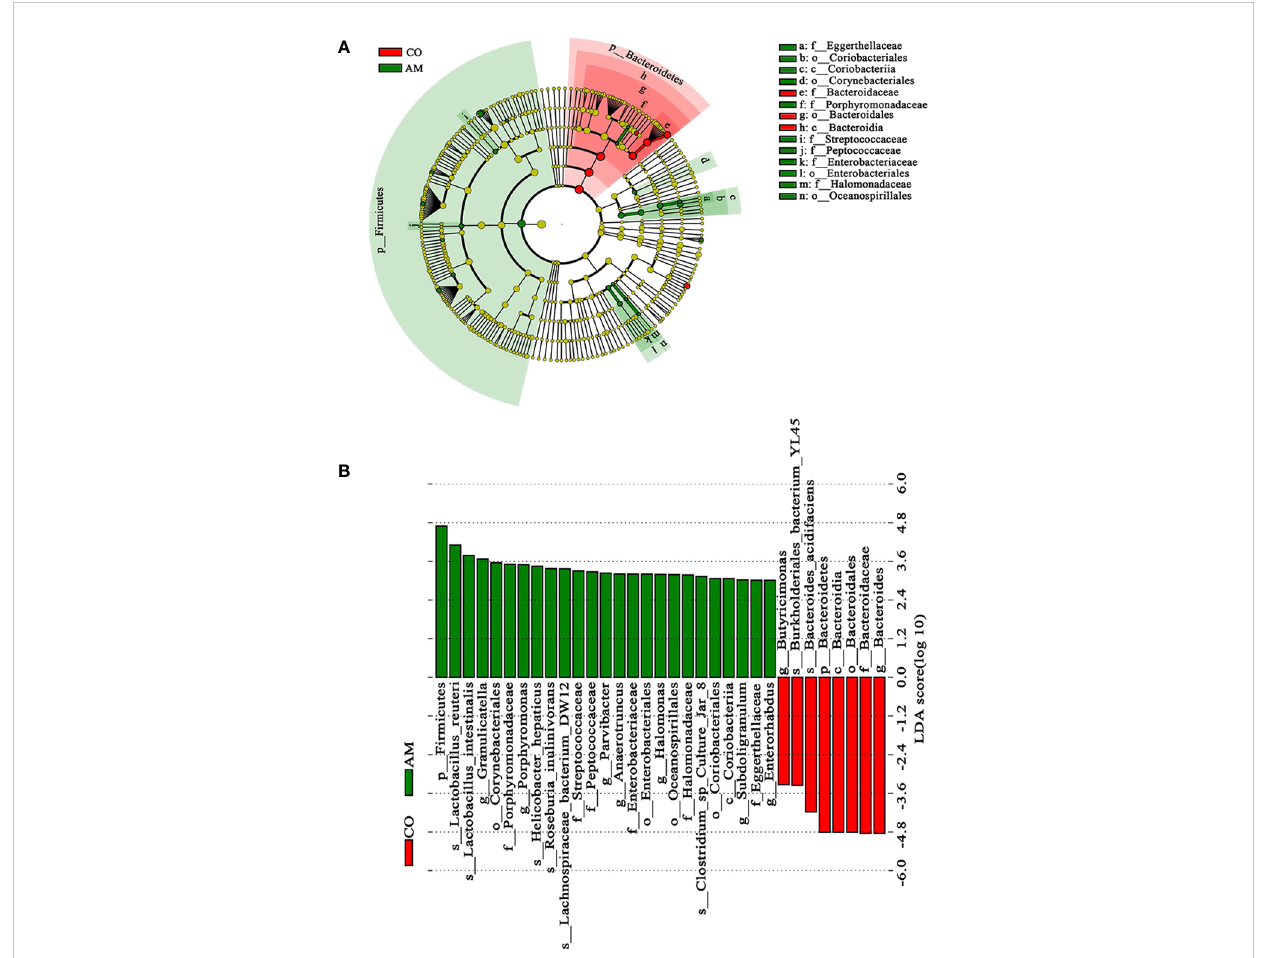
FIGURE 4 Linear discriminant analysis (LDA) integrated with effect size (LEfSe). (A) Cladogram indicating the phylogenetic distribution of microbiota. (B) The differences in relative abundance between the control and AM